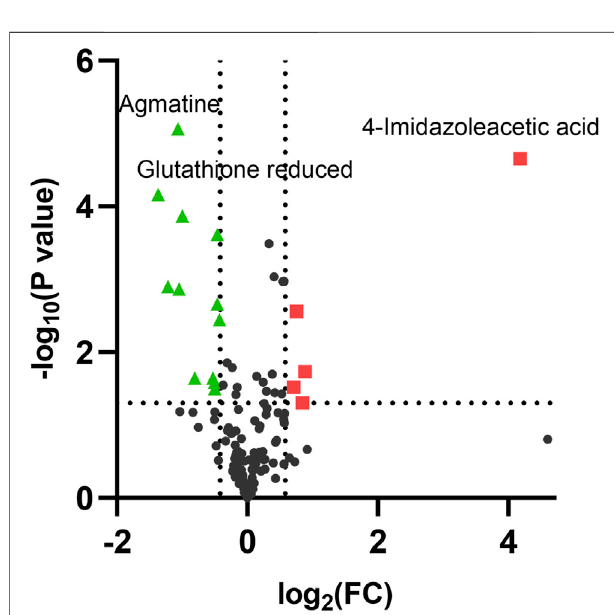
FIGURE 3 | Volcano plot analysis of differential metabolites in A549 cells afterexposureto80 μ MEGCG.The x -axisrepresentslog 2 (foldchange),while the y -axis represents p -value in -log 10 scale. The signi fi cantly up-regulated metabolites were indicated in red squares and down-regulated in green triangles. ( p < 0.05 and fold change > 1.5 or <